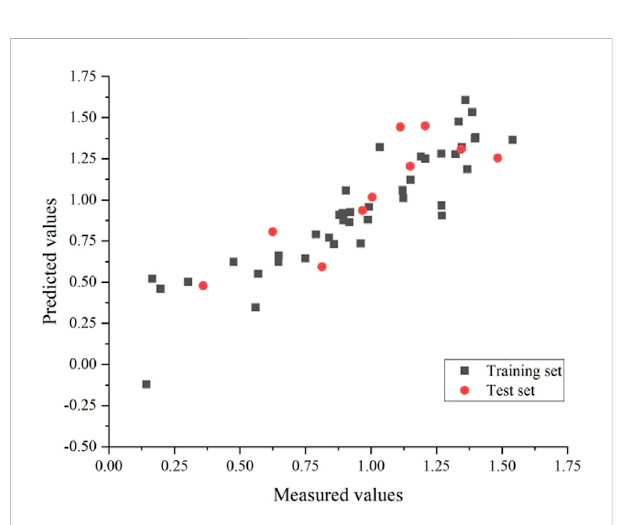
FIGURE 5 Plot of measured and predicted -log(IC 50 ) by GEP.